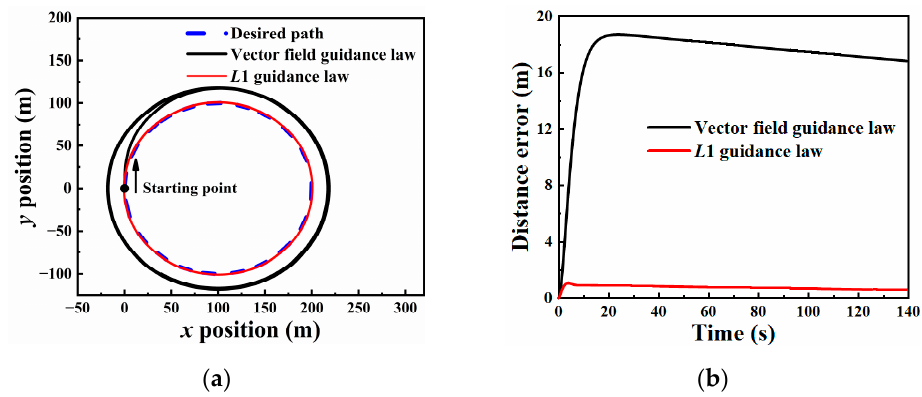
Figure 26. Comparison of vector field guidance law and L 1 guidance law: ( a ) flight trajectory; ( b ) distance error.